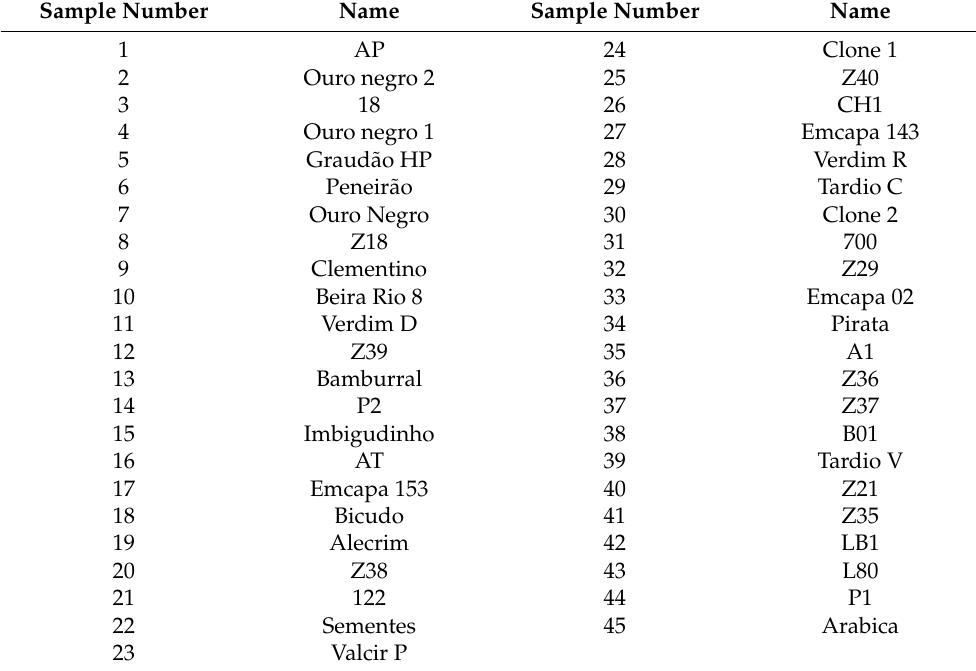
Table 3. Identification of Coffea canephora and Coffea arabica genotypes used for molecular